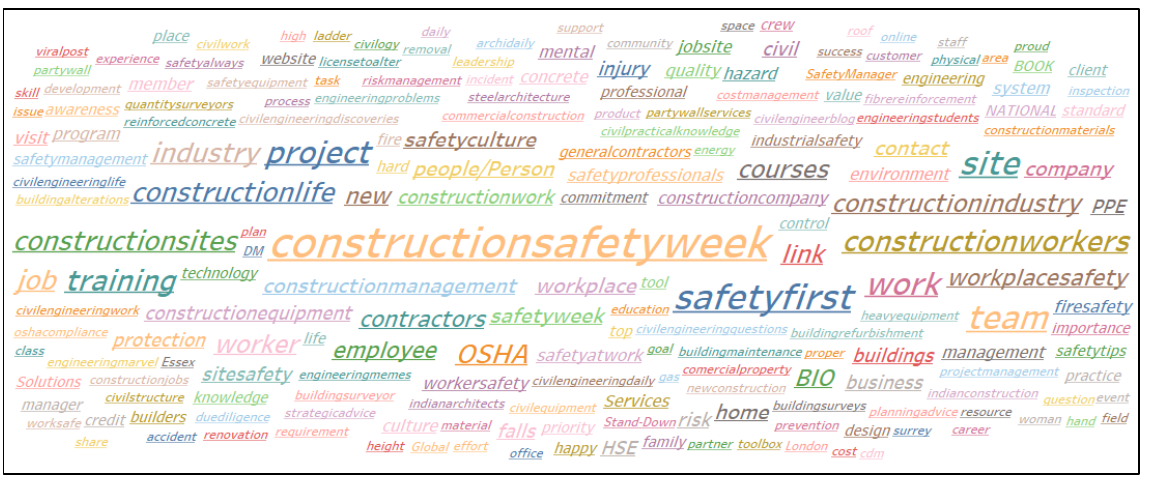
Figure 2. The influential keywords with high frequencies in construction health and safety on Instagram. Figure 2. Table 1. The top 20 keywords with higher term frequencies in construction health and safety on Instagram.